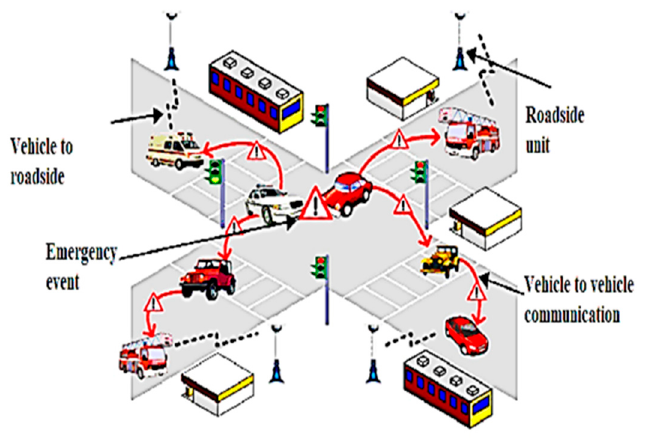
Figure 3. Vehicular ad hoc network and ITS.